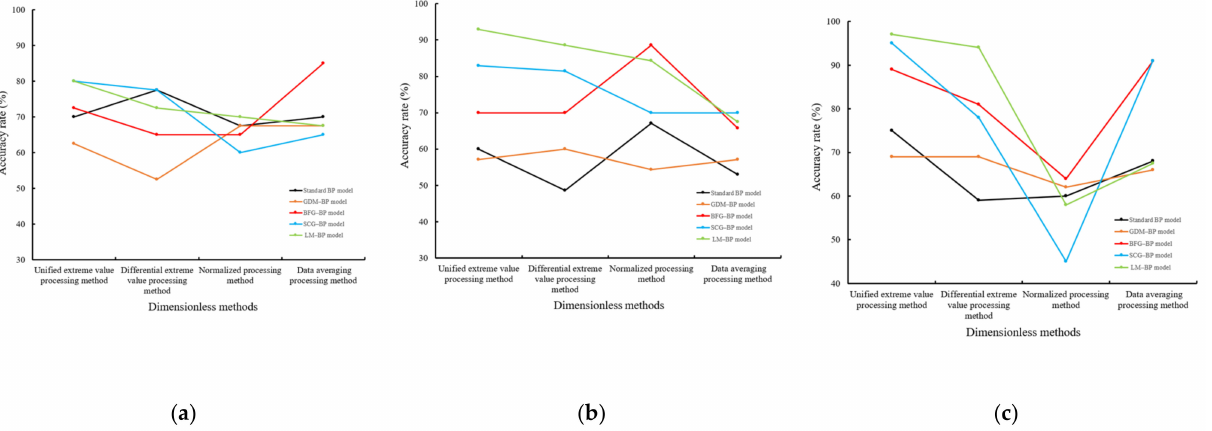
Figure 4. Model accuracy rate A under different dimensionless methods: ( a ) sample size 40; ( b ) sample size 70; ( c ) sample size